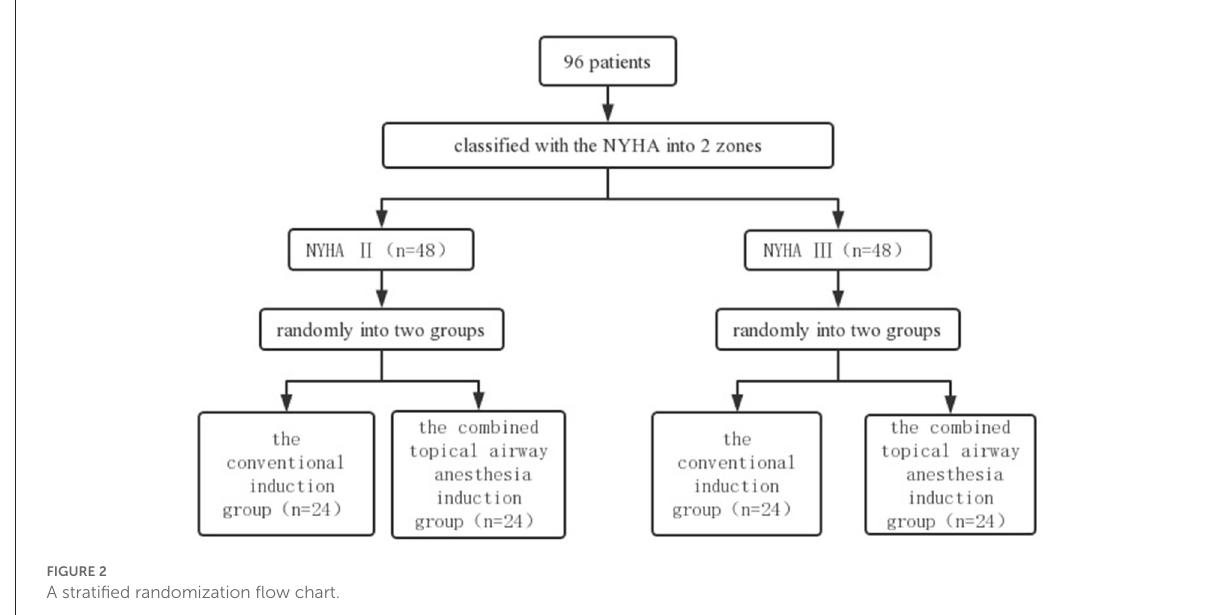
FIGURE2 A stratified randomization flow chart.